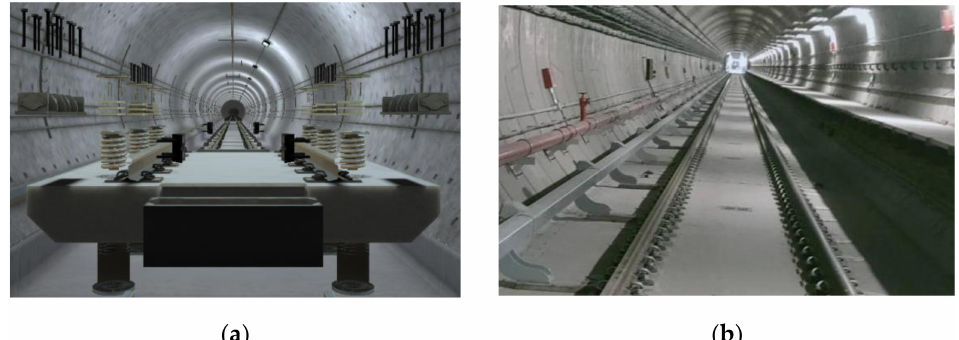
Figure 3. Steel-spring-floating slab track layout in the tunnel. ( a ) Structure split diagram; ( b ) site in the